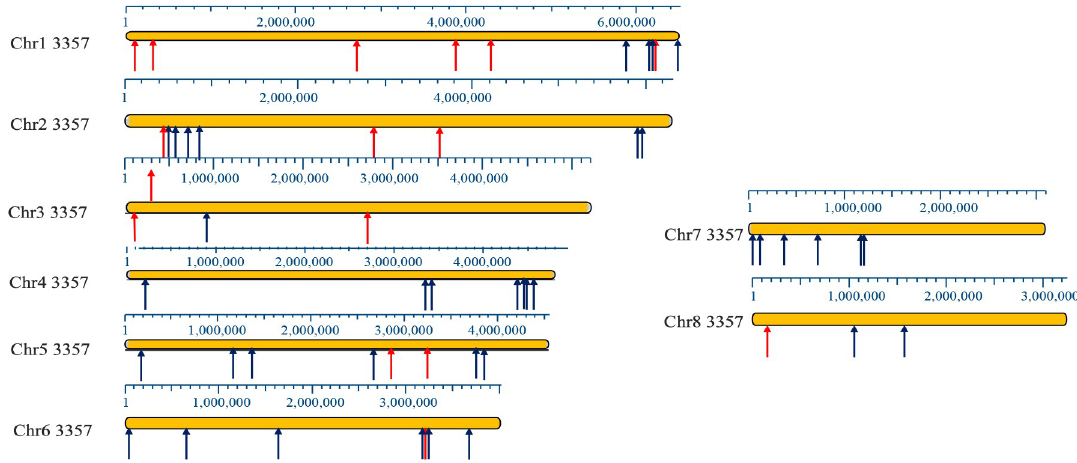
Fig 1. Distribution map of unique indels in A . flavus